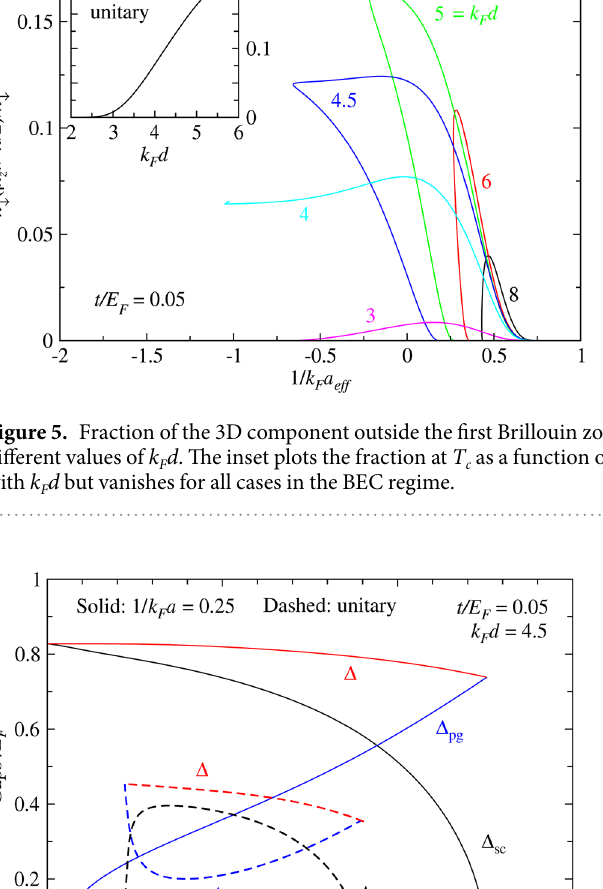
(blue curves), as a pg